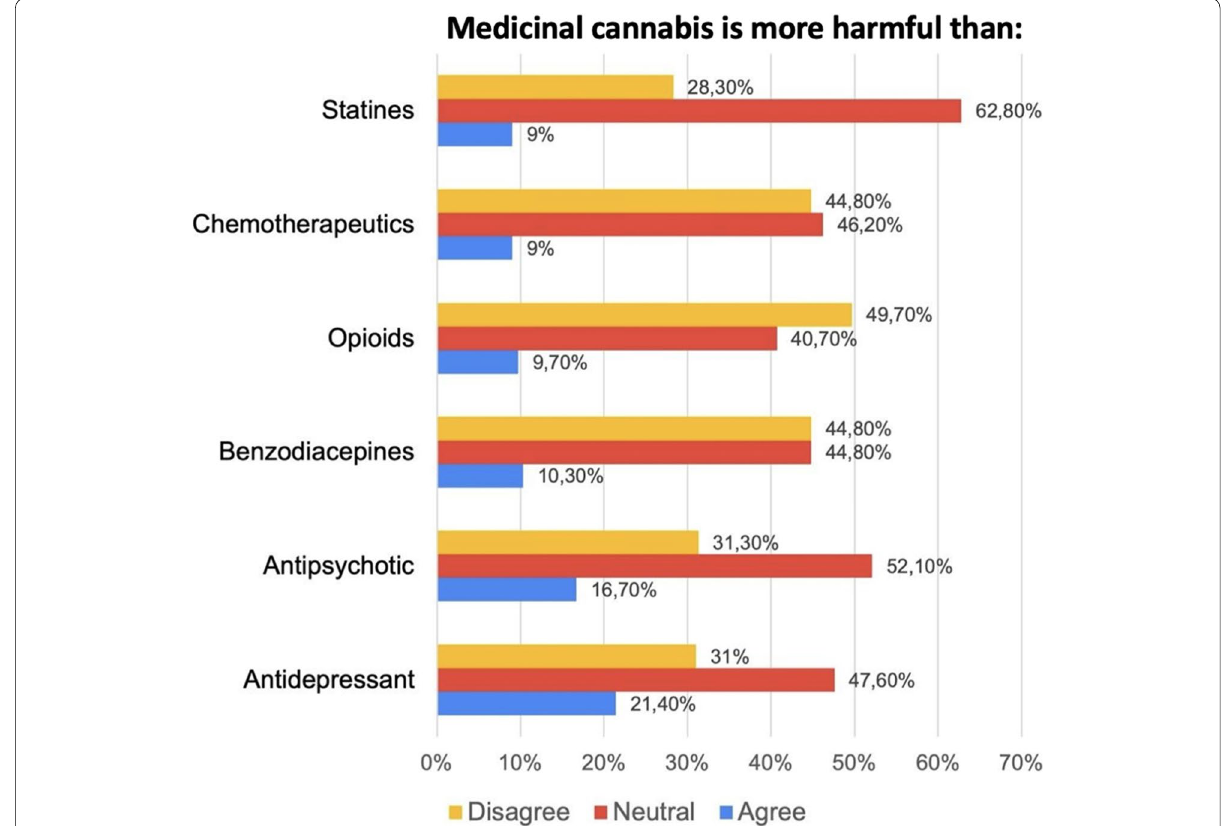
Fig. 4 Ratings of relative hazards of medicinal cannabis compared with other prescription medicines among 145 Colombian psychiatrists. Most of the psychiatrists surveyed were neutral about or disagreed with whether cannabis was more harmful than other